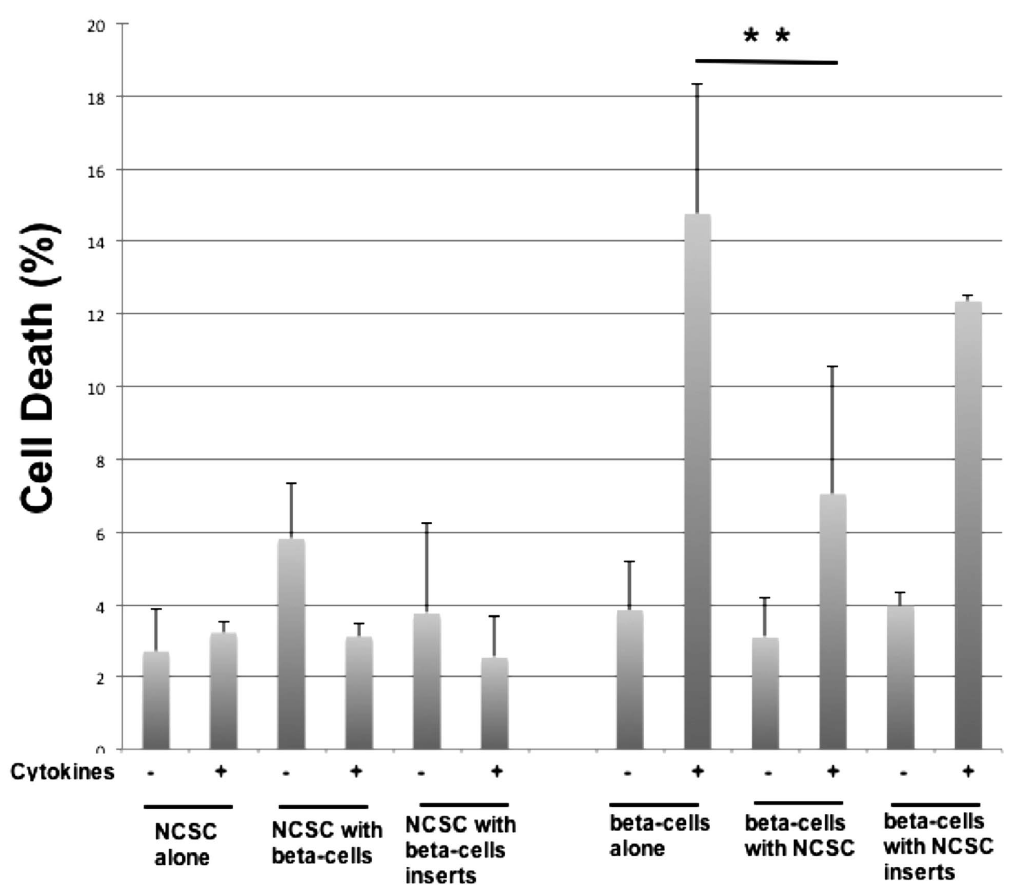
Figure 1. Co-culture of beta-TC6 cells with NCSCs in direct contact results in protection against cytokine-induced beta-cell death. NCSCs were plated on laminin-coated plates or inserts and after three days beta-TC6 cells were added. After another 48 hours, IL-1 b (20 ng/mL) and IFN- b (20 ng/mL) was added. 48 hours later cells were labeled with propidium iodide, trypsinised and analysed for cell death by flow cytometry. GFP- positive cells (NCSCs) and GFP-negative cells (beta-TC6) were gated and analysed separately. Results are means 6 SEM for 5 independent experiments. ** denotes p , 0.01 using Student’s paired t-test.